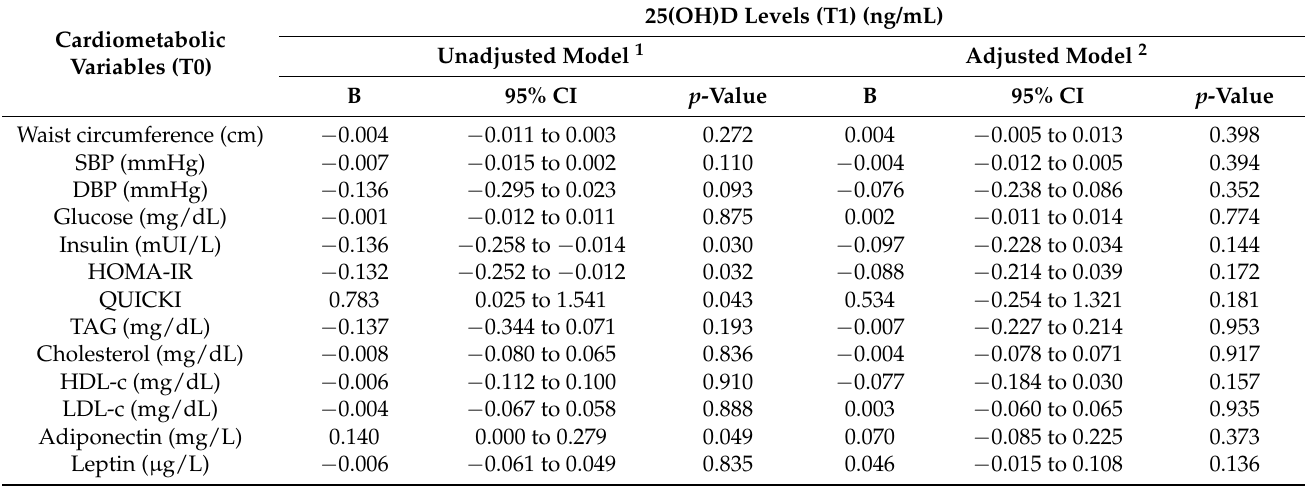
Table 3. Multivariable linear regression analysis between cardiometabolic variables at the prepubertal stage (T0) and 25(OH)D levels in the pubertal stage